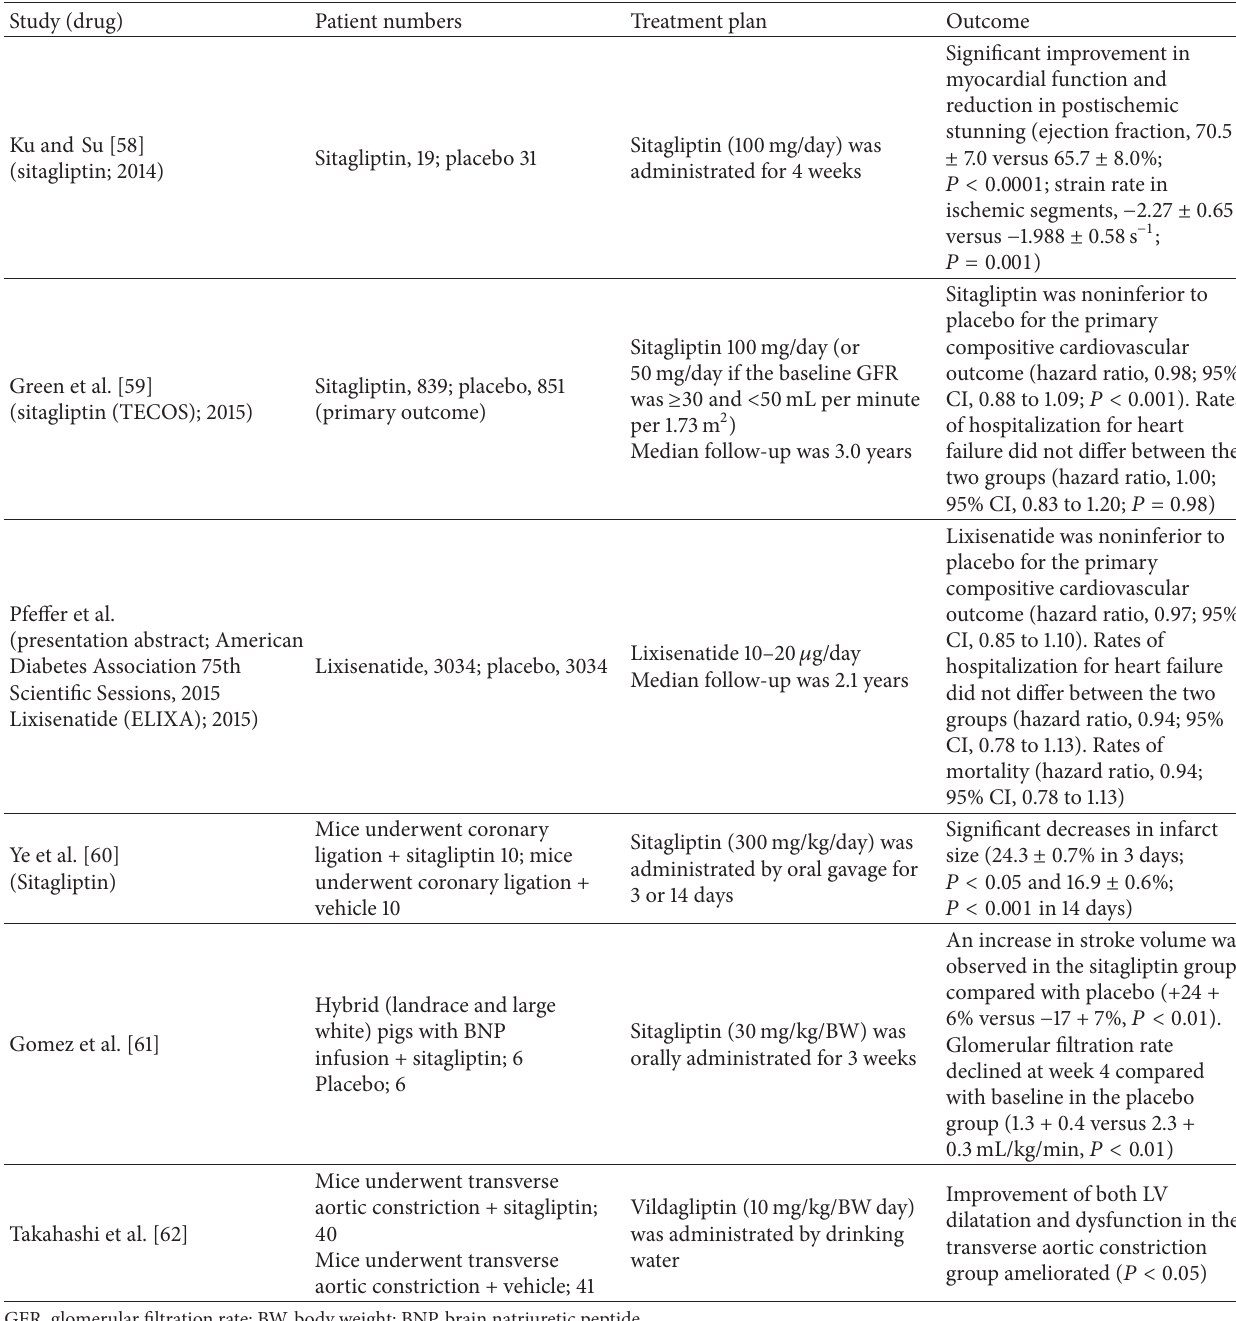
Table 2: Clinical trials and animal studies of selected incretin-based agents for cardiovascular